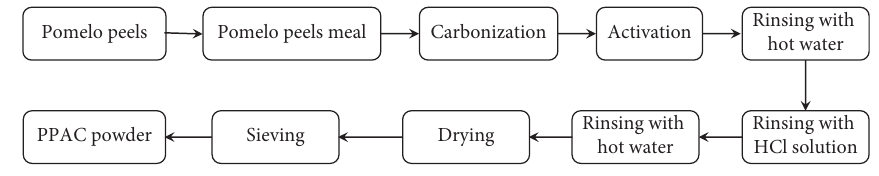
Figure 3: Brief preparation process of PPAC. Table 1: Levels of parameters in an orthogonal experiment.